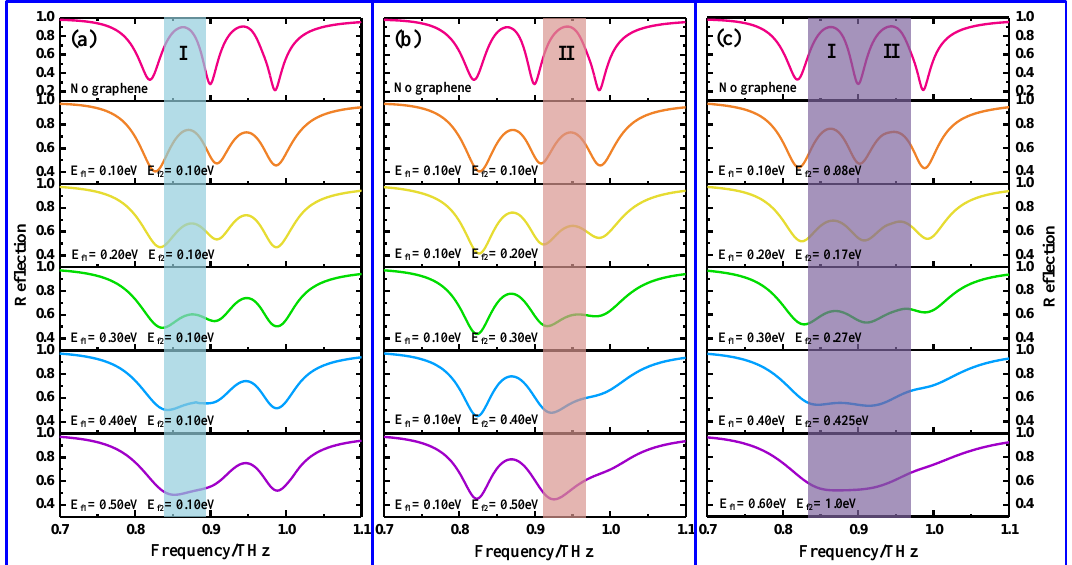
Figure 4. Simulated reflectance spectra for three different modulation ways: ( a ) shifting E f1 only, ( b ) shifting E f2 only, and ( c ) simultaneously shifting E f1 and E f2 .